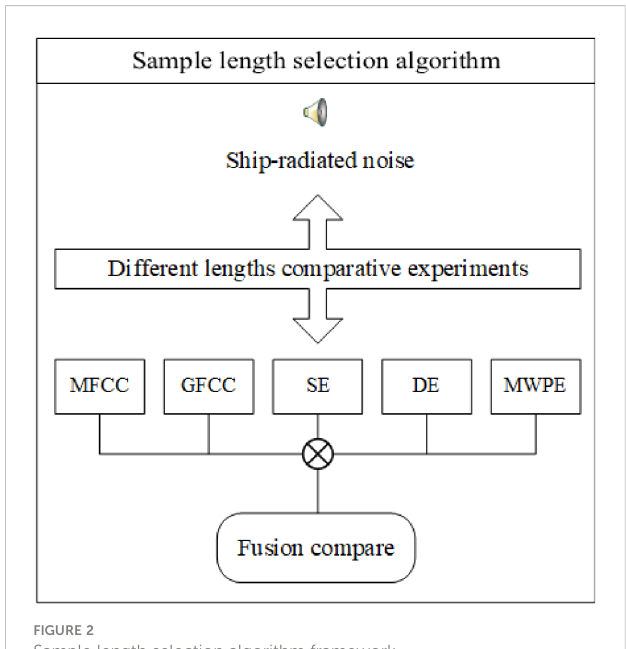
FIGURE 2 Sample length selection algorithm framework.